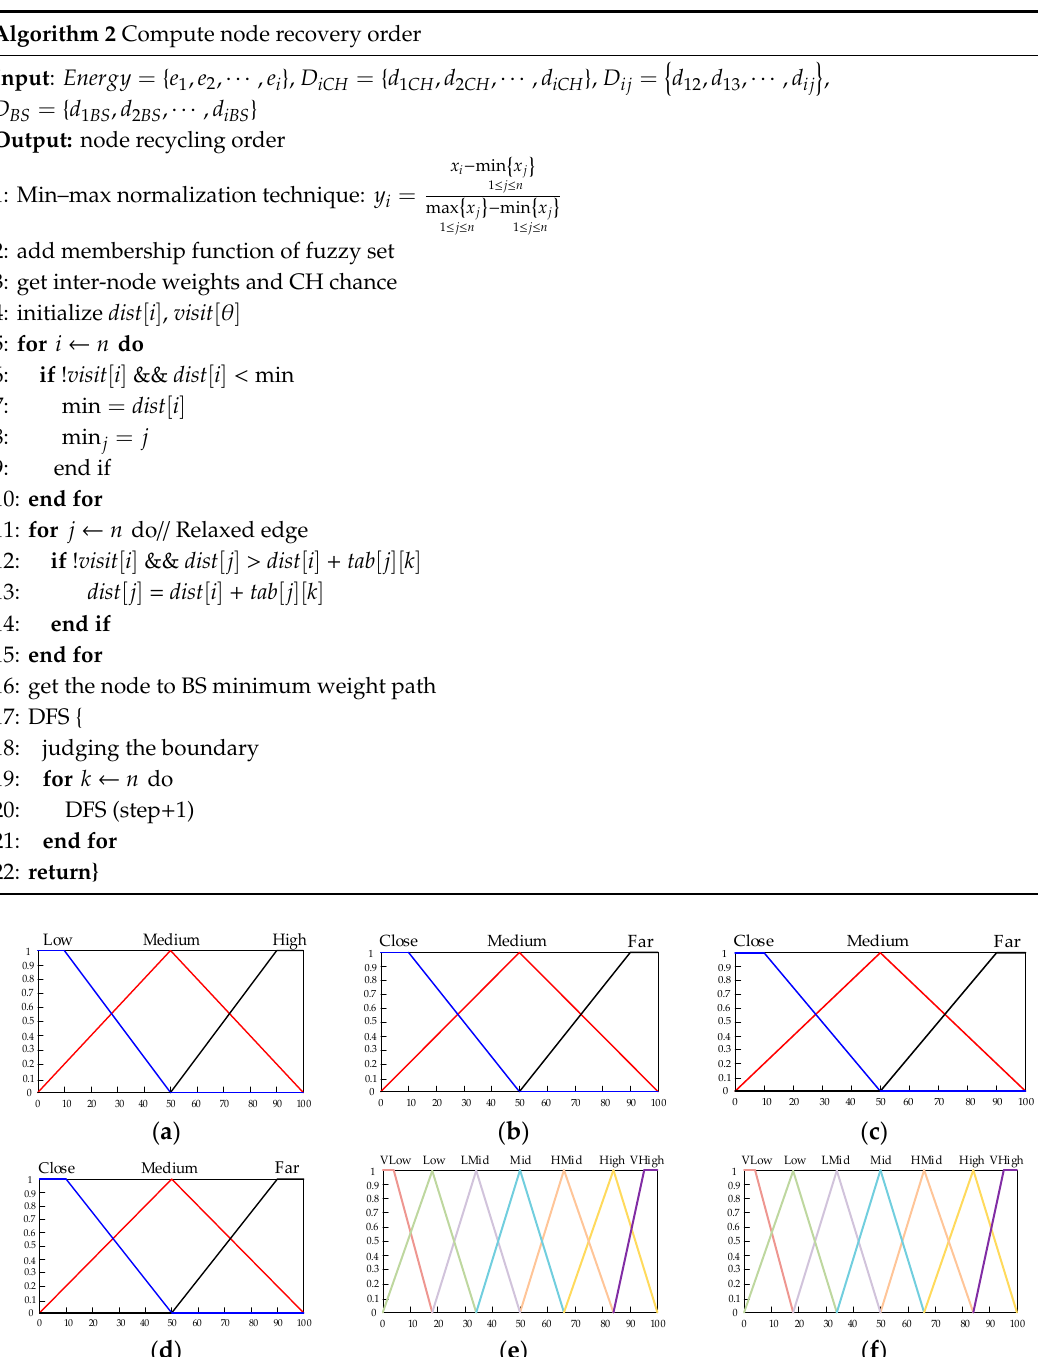
Table 1. Linguistic variables.